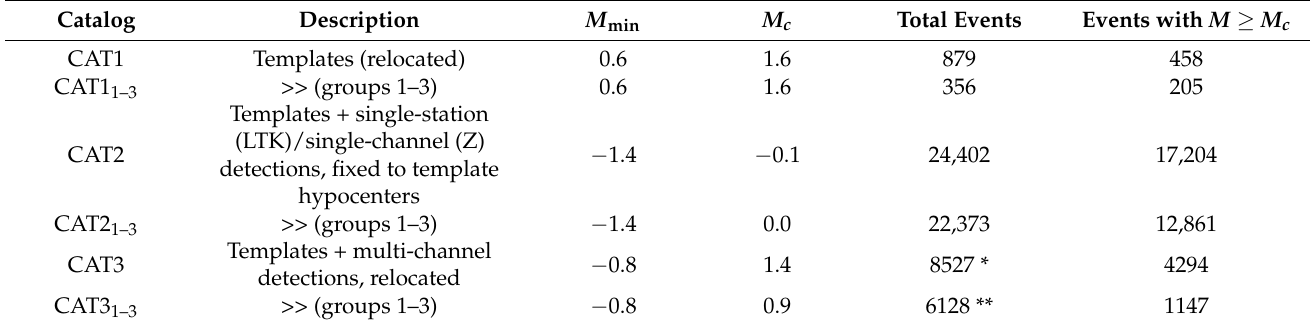
Table 1. Information on events contained in the three catalogs produced in this study. CATX 1–3 refers to the catalog for spatial groups 1–3. M min denotes the minimum magnitude and M c the magnitude of completeness, as determined by the GoF test for 95%